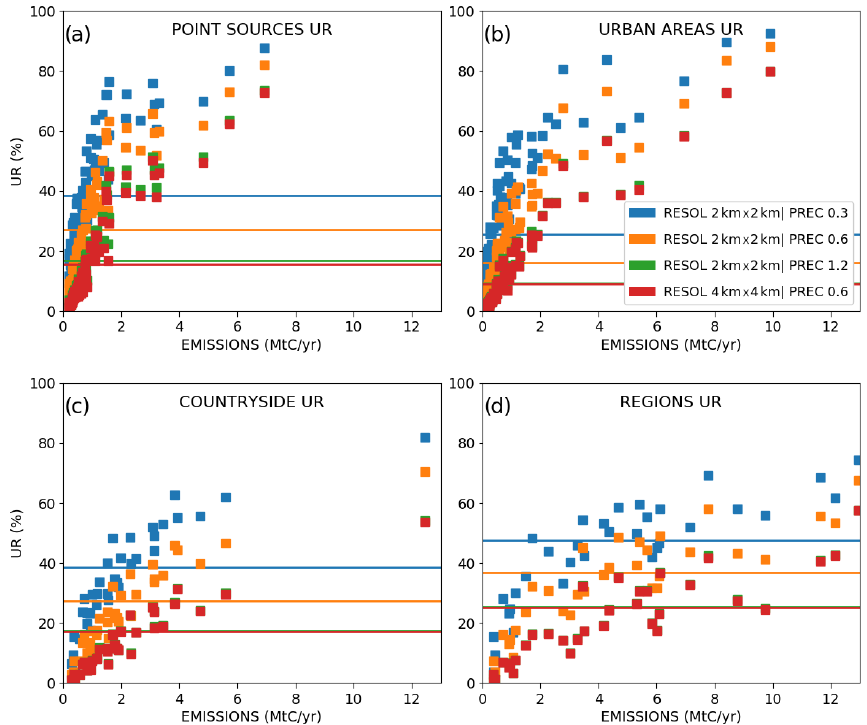
Figure 11. Same as Fig. 7 but the inversions are performed with different retrieval resolutions and precisions (swath = 900km). Prior uncertainties in the 6h budgets of the point sources, urban and countryside areas are taken to be equal to